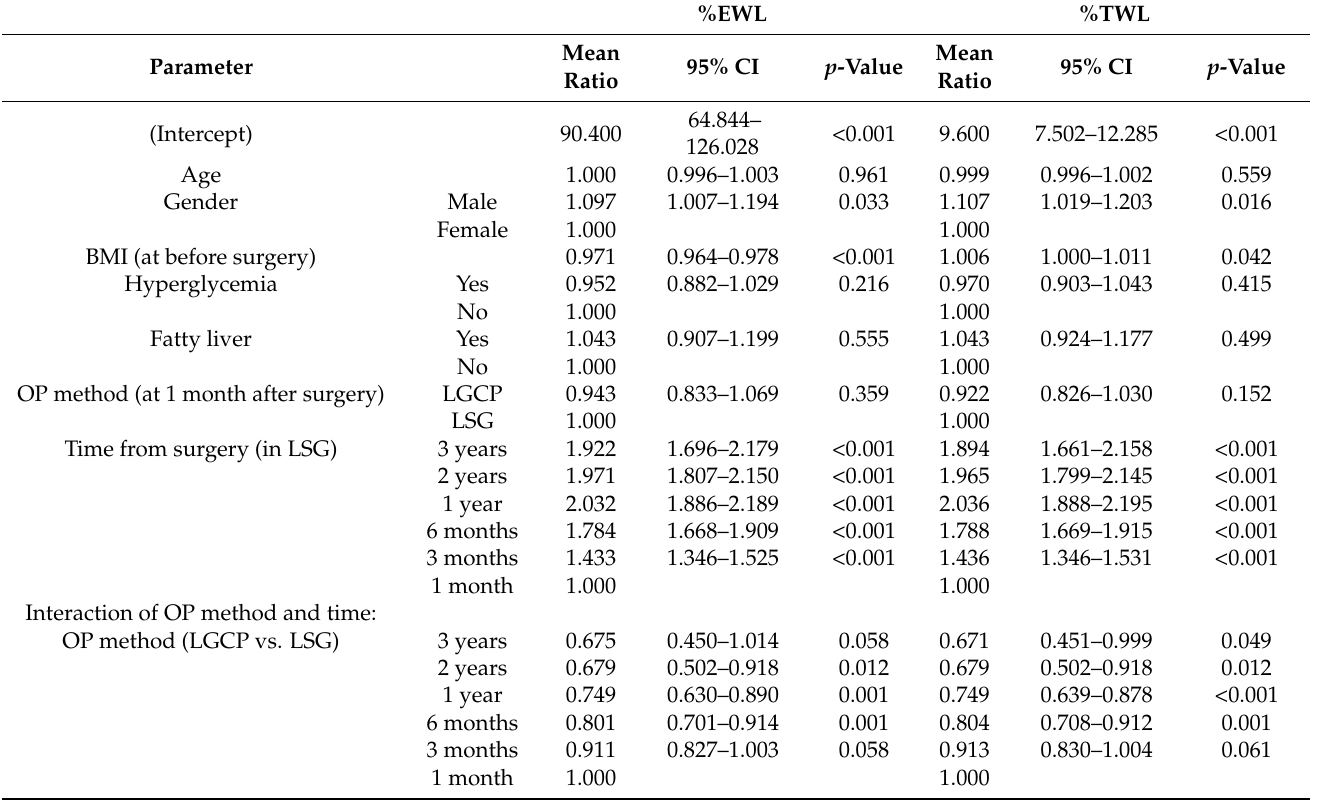
Table 3. Results of multiple generalized linear models with log link and gamma distribution in GEE method on %EWL and %TWL.